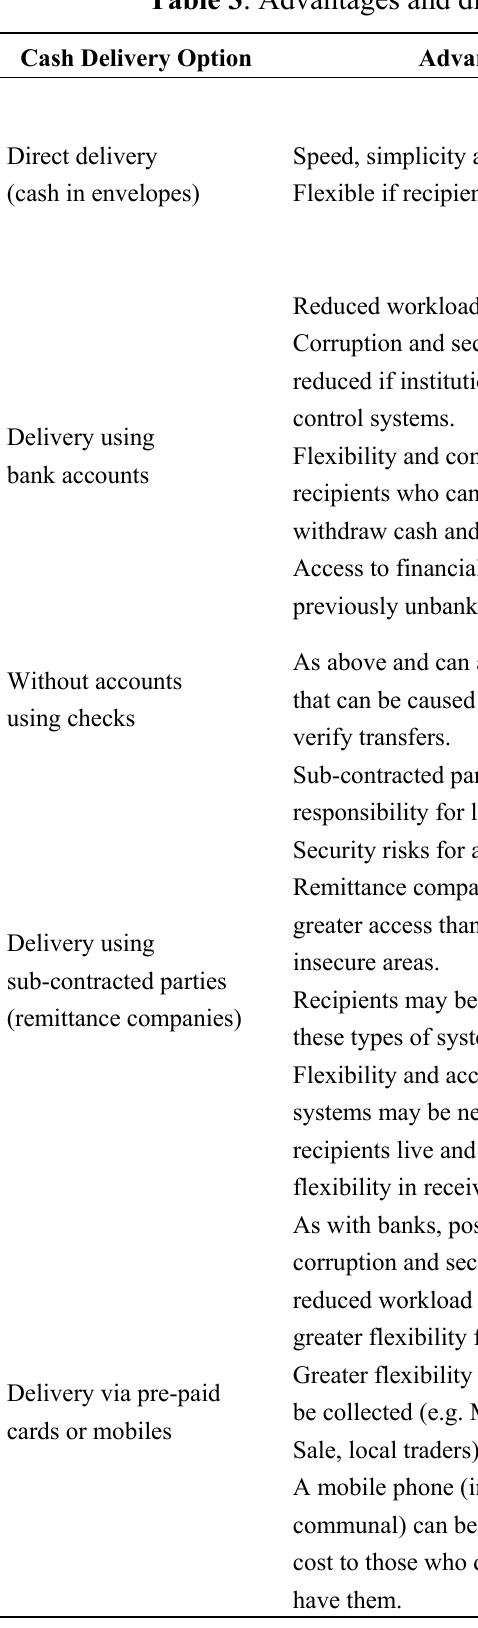
Table 3 . Advantages and disadvantages of different cash delivery